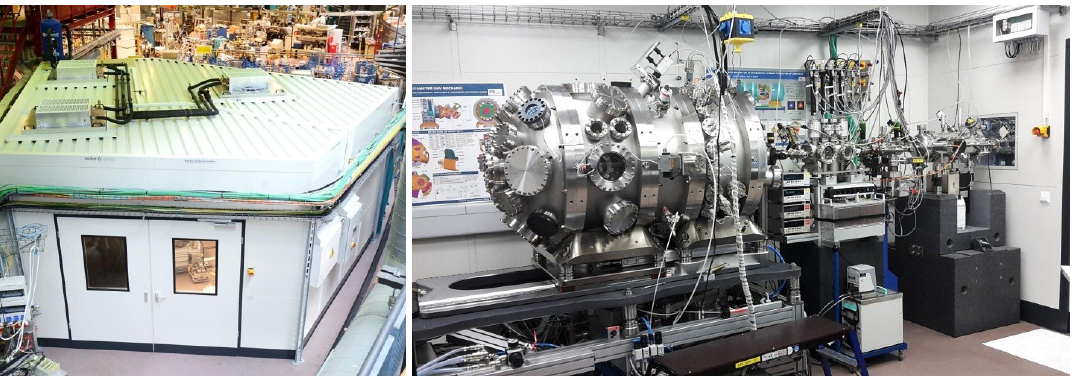
Figure 3: The clean-room hutch at the experimental floor of BESSY-II with the M4-mirror chamber, the Filter and Slit Unit (FSU) and the Reflectometer inside (Light comes from the right